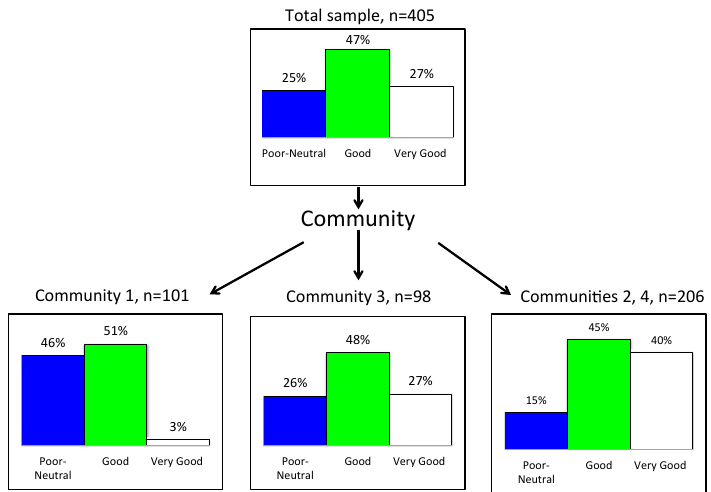
Figure 8. CHAID segmentation of sample by general health.